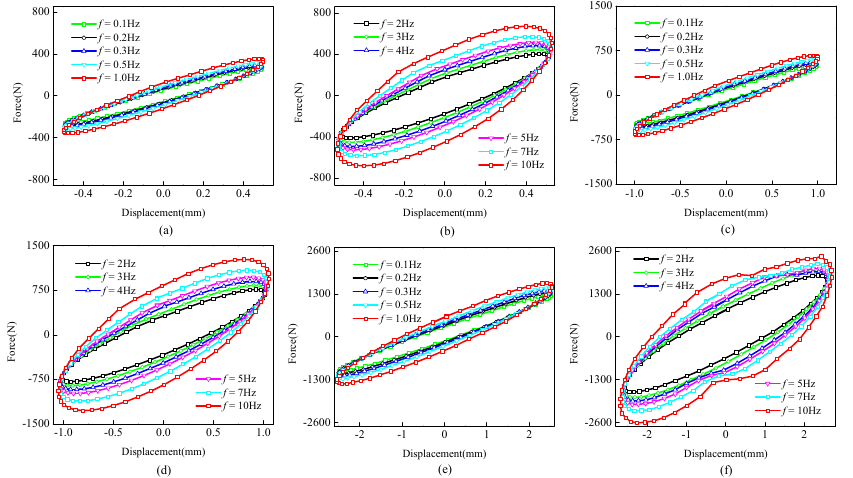
Figure 2. Hysteretic curves of the viscoelastic damper with changing frequencies. ( a ) d = 0.5 mm, f = 0.1 ~ 1 Hz. ( b ) d = 0.5 mm, f = 2 ~ 10 Hz. ( c ) d = 1 mm, f = 0.1 ~ 1 Hz. ( d ) d = 1 mm, f = 2 ~ 10 Hz. ( e ) d = 2.5 mm, f = 0.1 ~ 1 Hz. ( f ) d = 2.5 mm, f = 2 ~ 10 Hz.